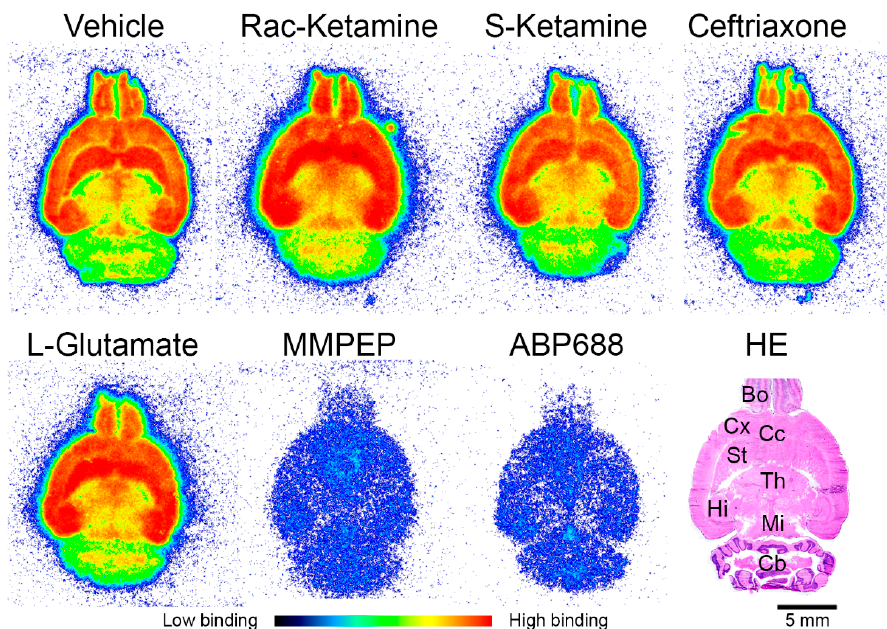
Figure 1. Representative in vitro autoradiograms of a rat brain incubated with 1 nM [ 18 F]PSS232 solution supplemented with vehicle (0.9% NaCl), racemic ketamine, S-ketamine, ceftriaxone, L-glutamate, MMPEP ((2-[2-(3-methoxyphenyl)ethynyl]-6-methylpyridine hydrochloride) or ABP688 (( Z )- N -methoxy-3-[2-(6-methylpyridin-2-yl)ethynyl]-cyclohex-2-en-1-imine) (each 1 µM). [ 18 F]PSS232 binding was strong to bulbus olfactorius (Bo), cortex (Cx), cortex cingulate (Cc), striatum (St) and hippocampus (Hi). Moderate binding was observed to thalamus (Th) and midbrain (Mi) and low binding to cerebellum (Cb). Color bar indicates low and high binding. Hematoxylin/eosin (HE) staining shows rat brain morphology. Scale bar: 5 mm.